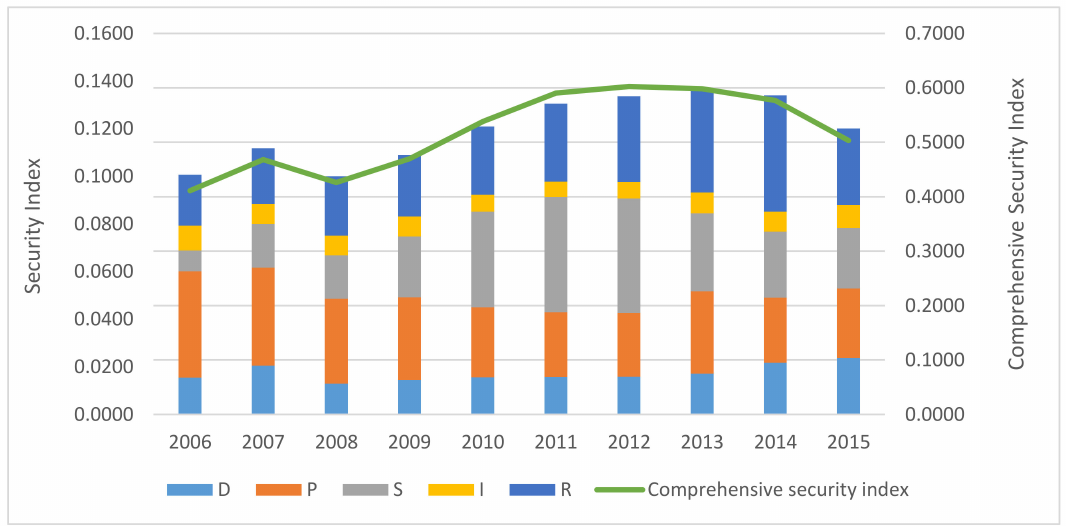
Figure 7. Time-series graph for the coordinated security of the five subsystems from 2006–2015.